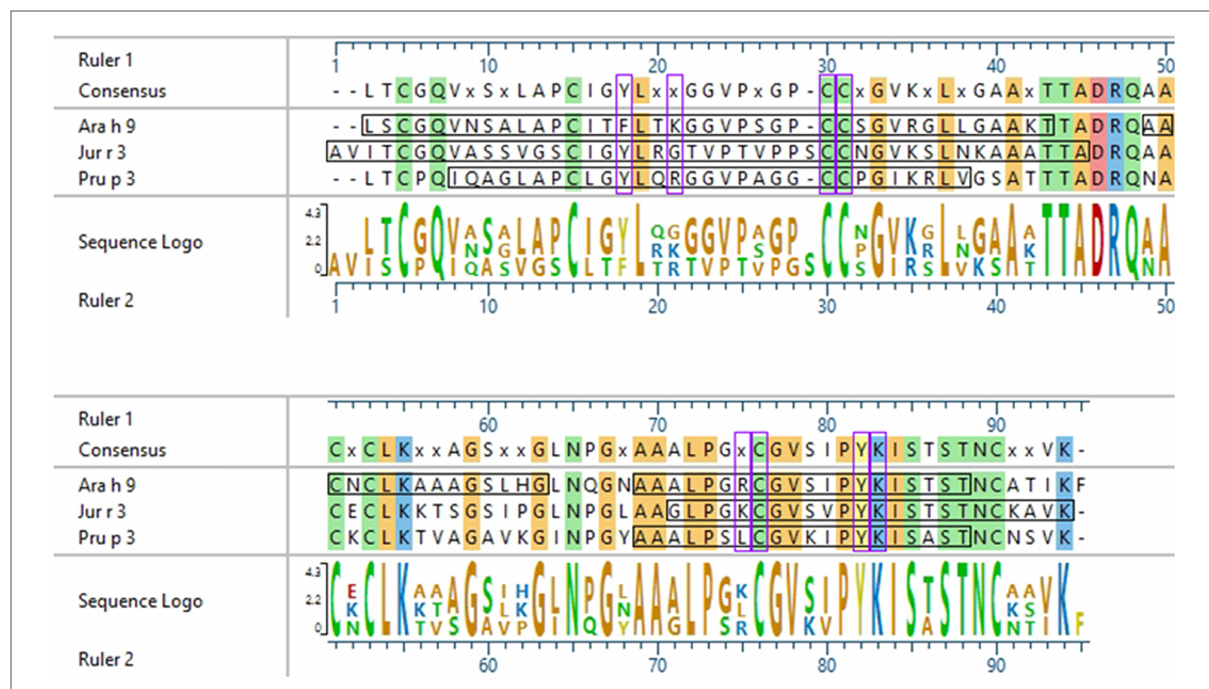
FIGURE 3 Sequence alignment of Ara h 9, Jug r 3, and Pru p 3. ClustalW (Clustal W2, RRID:SCR_002909) sequence alignment between Ara h 9.0201, Jug r 3.0101, and Pru p 3.03. Consensus sequence is shown above the alignment. Horizontal black boxes indicate IgE binding epitopes from US sera identi fi ed in this study. Colored vertical highlights show the conserved amino acids. Amino acids are color coded based on chemistry. Vertical purple boxes indicate basic (K and R), polar ( C ), or aromatic (F and Y) residues within peptides 4, 14, and 15 of Ara h 9 that are conserved or semi-conserved.